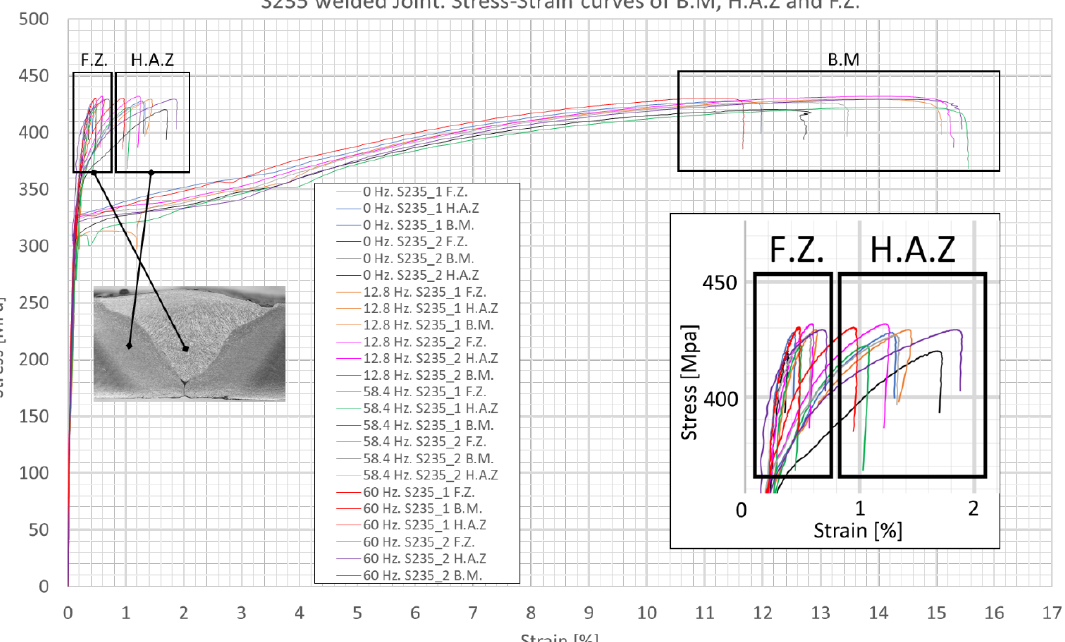
Figure 12. Tensile test curves for S235 steel welds, revealing the local mechanical properties of different weld zones.